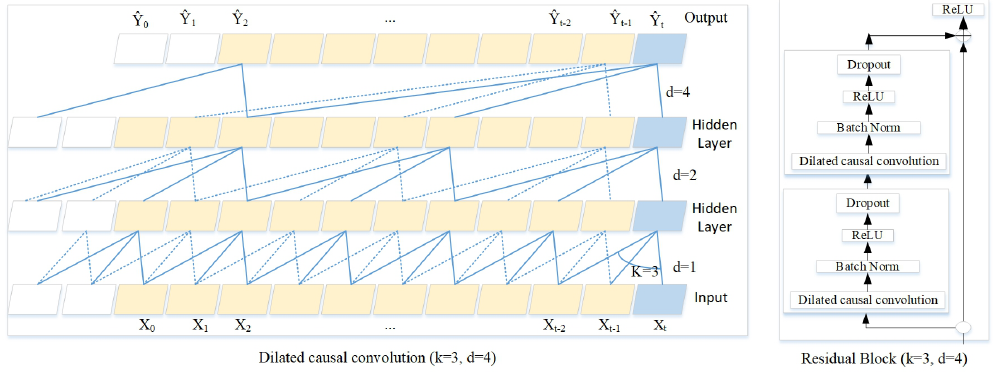
Figure 7. Dilated causal convolution with dilation rate d = 4, filter size k = 3 and residual block.